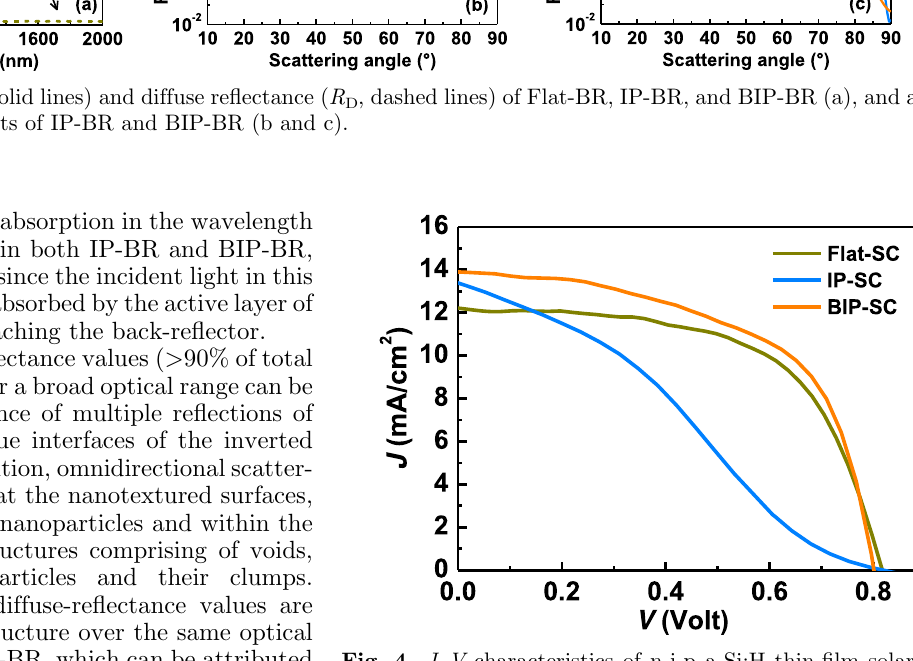
Fig. 4. J – V characteristics of n-i-p a-Si:H thin- fi lm solar cells made on Flat-BR, IP-BR, and